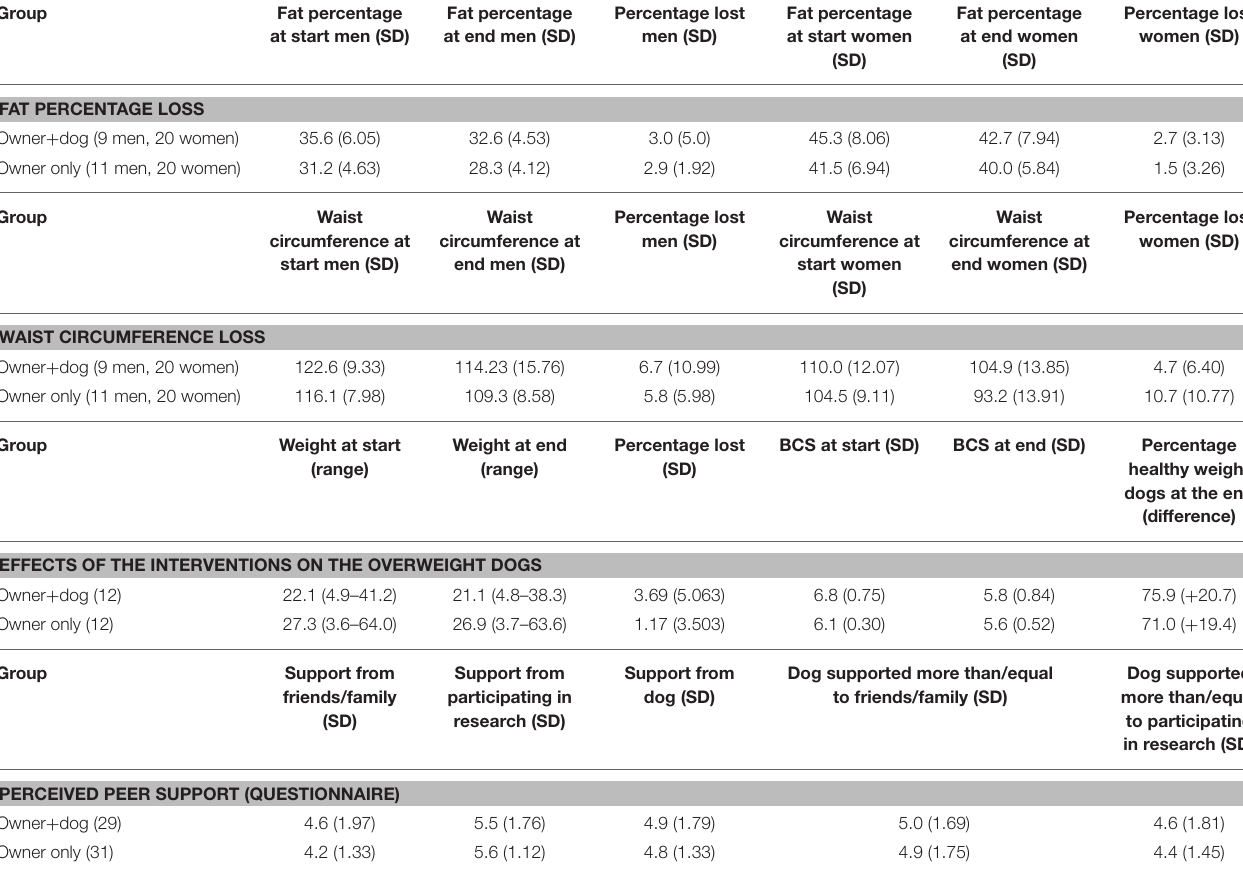
TABLE 3 | Other weight loss parameters, effects on overweight dogs, and perceived peer support, human-centered trial. Group